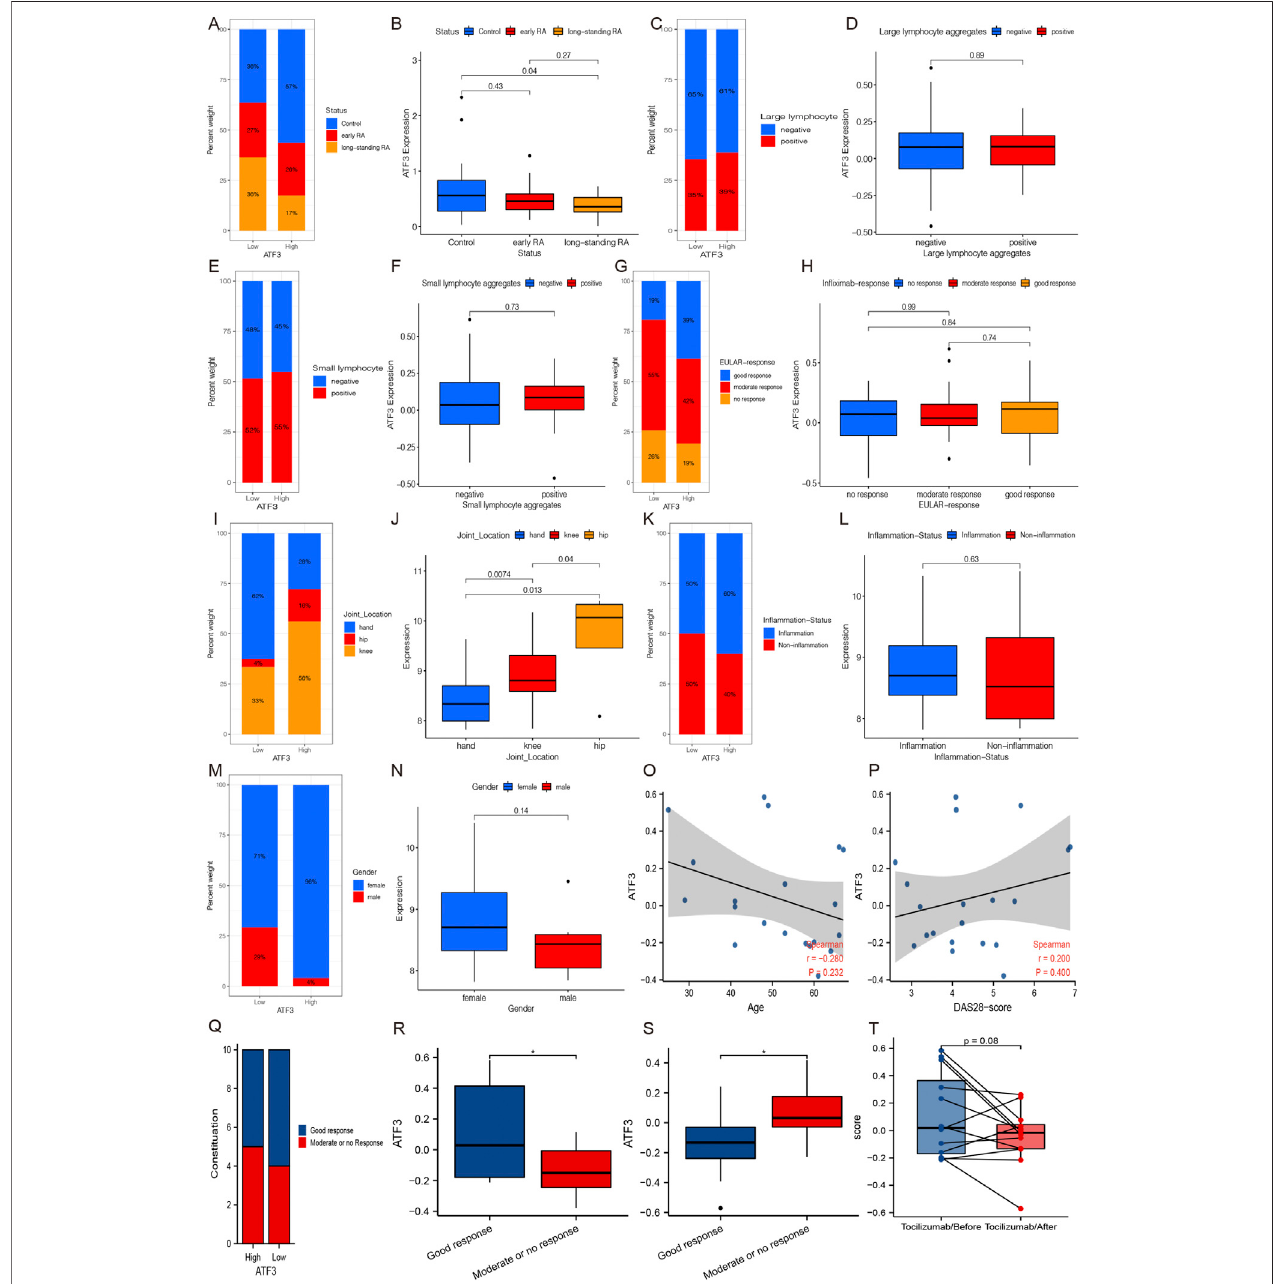
FIGURE 6 | The relationships between ATF3 and clinical parameters. (A and B) GSE13026 shows that ATF3 in long-standing rheumatoid arthritis (RA) patients is signi fi cantly lower than that in normal individuals, and its expression in long-standing RA patients seemed lower than that in early RA patients. (C and D) Large lymphocyte aggregation status in synovium seemed to have no relationships with ATF3 expression in GSE21537. (E and F) Similarly, small lymphocyte aggregation statusstillhasnorelationshipwithATF3inGSE21537. (GandH) Patientswithgoodin fl iximabresponseaccountedforahigherpercentageinthehighATF3group, but thedifferenceofATF3amongdifferentin fl iximab-responsegroupswasnotsigni fi cant. (IandJ) GSE48780indicatesthatATF3expression wassigni fi cantlydifferent among different joint synovium and its expression in hip synovium was signi fi cantly higher than that in knees and hands. (K and L) ATF3 in in fl ammation-in fi ltrated synovium was slightly higher than that in non-in fl ammation synovium, and patients with in fl ammation-in fi ltrated synovium accounted for a higher percentage in the high ATF3 group. (M and N) ATF3 expression seemed higher in female patients in GSE48780. ATF3 had a slight decrease along with the increment of age (O) , while there was a positive correlation between ATF3 and DAS-28 score (P) , an index to evaluate RA activity. (Q and R) ATF3 expression in RA patients with a good response was signi fi cantly higher than that in patients with a limited response before treatment with tocilizumab or methotrexate. (S and T) ATF3 expression in RA synovium after treatment was signi fi cantly lower in patients with good response, especially treatment with tocilizumab.